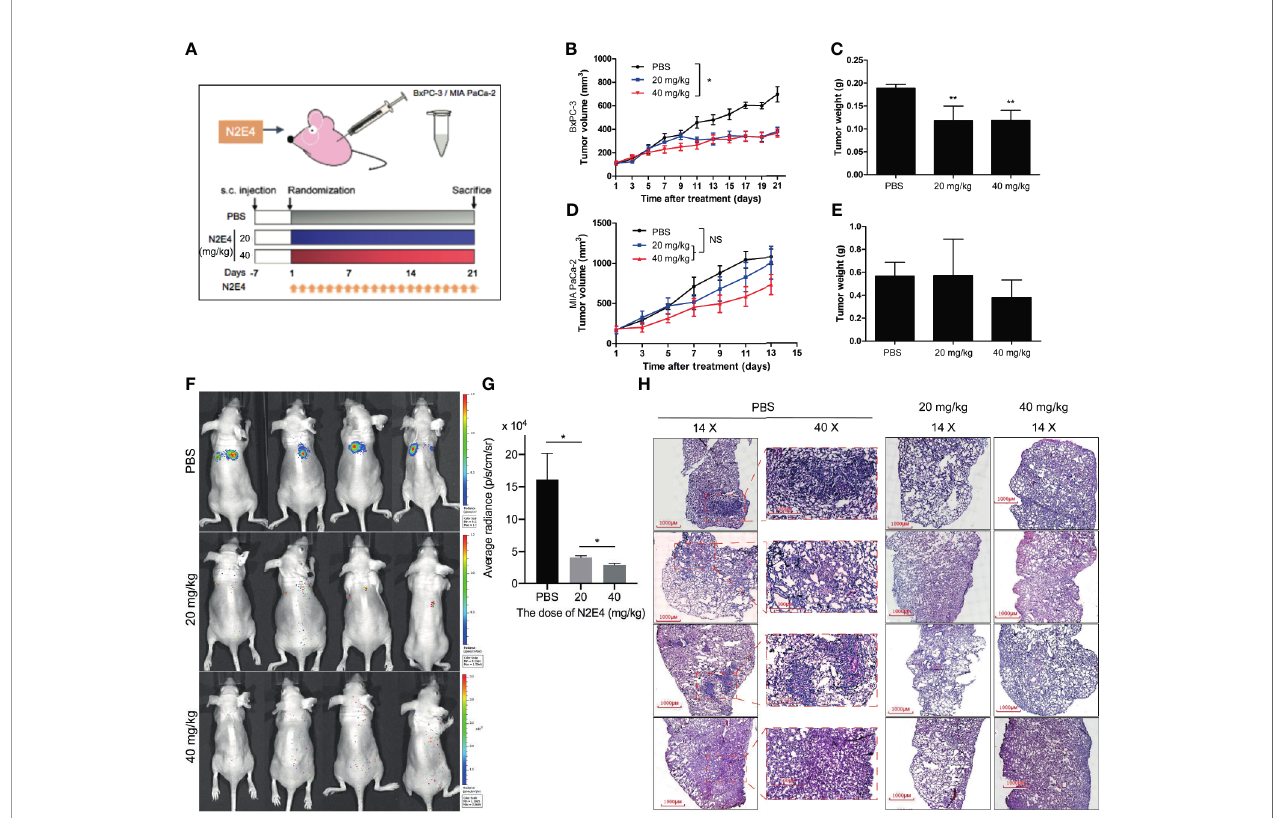
FIGURE 6 | Antitumor effects of N2E4 on pancreatic cancer xenografts. (A) BxPC-3 and MIA PaCa-2 cells (5 x 10 6 ) were subcutaneously injected into 4~6-week- old female BALB/c nude mice. When tumor volume reached 40 ~ 70 mm 3 , mice were randomly divided into different groups and treated with PBS, low dose (20 mg/kg), and high dose (40 mg/kg) of N2E4 once daily via tail vein injection. (B, D) Tumor volume curves. (C, E) The average weight of the isolated tumor tissues in each group. (F, G) Representative images and quantitative analysis of lung metastasis were determined by luciferase-based bioluminescence imaging. (H) Metastasis nodules from isolated lungs were evaluated by tissue section H&E staining. * P < 0.05; ** P < 0.01. NS, no signi fi